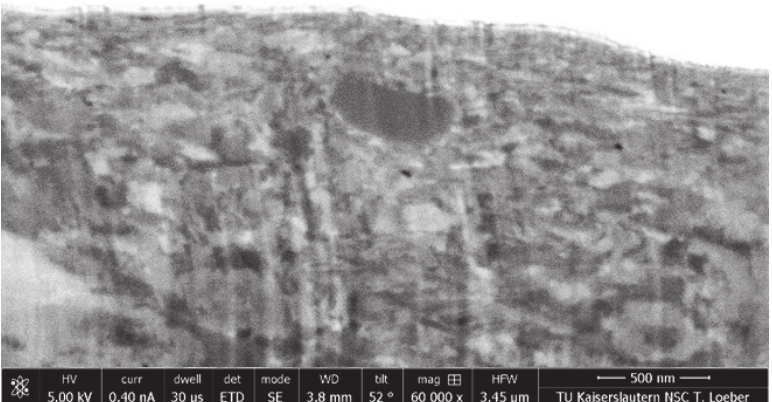
Figure 3: SEM image of grain refinement and a carbide in the surface layer.